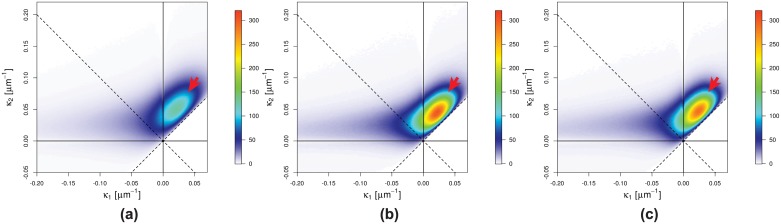
ISD plots.Interface shape distributions (ISD) for the free different pressures: (a) 10 cmH2O; (b) 20 cmH2O; (c) 30 cmH2O. The arrows indicate the shift towards smaller principle curvatures (larger radii).